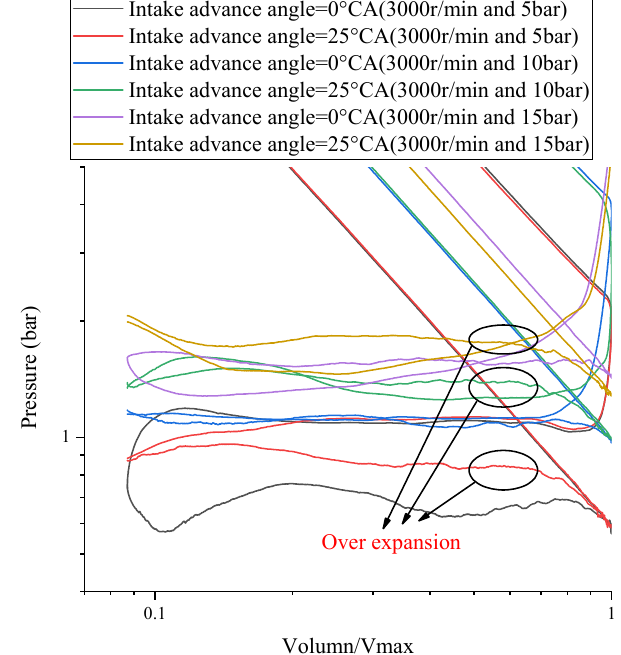
Figure 7. The logP versus logV diagram relative to intake advance angle under baseline EVC at different points of operation.